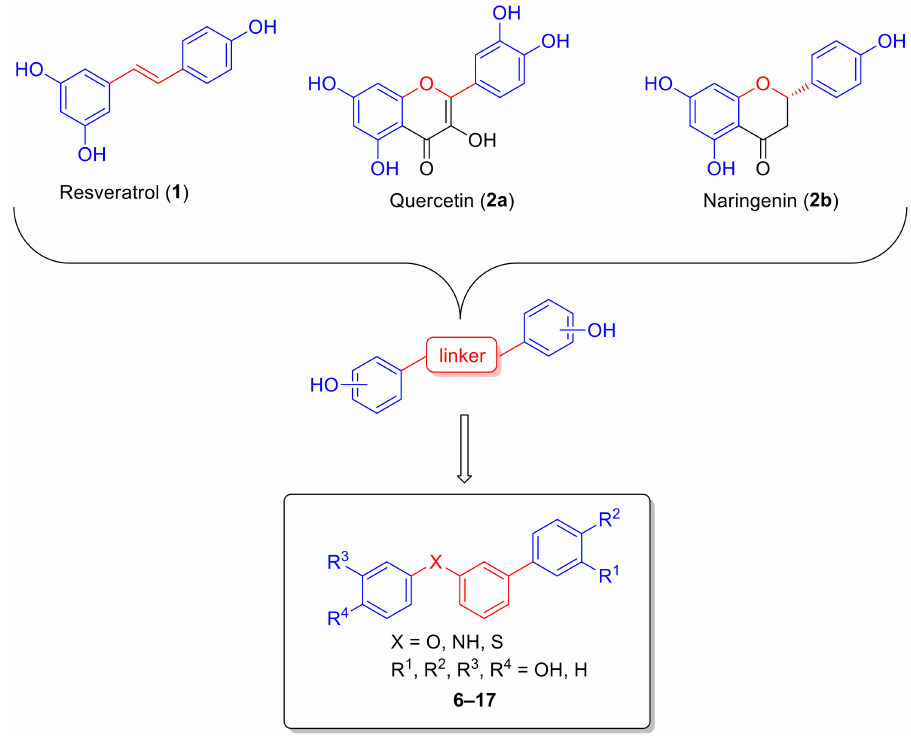
Figure 2. Design of new SIRT1-activating compounds. Structure of resveratrol 1 , quercetin 2a and naringenin 2b and schematic representation of their scaffold (phenolic rings in blue and linker portions in red); general structure of the new derivatives 6 – 17 (in the